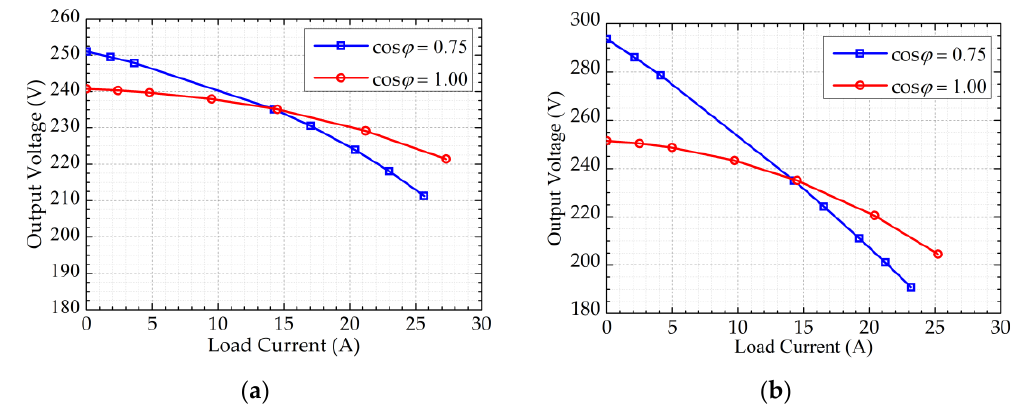
Figure 19. External characteristics of the BSG: ( a ) External characteristics at 6795 rpm; ( b ) External characteristics at 9615 rpm.